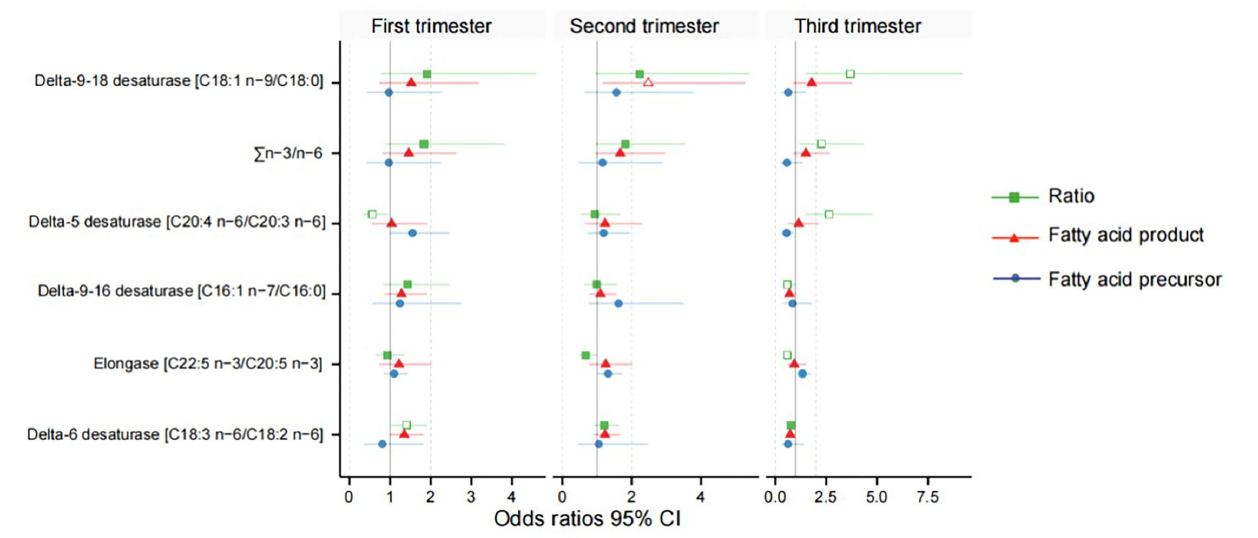
FIGURE 3 | Odds ratios between the desaturase activities and gestational diabetes mellitus. Green indicates the fatty acid product-to-precursor ratios; red indicates the fatty acid product; blue indicates the fatty acid precursor. A hollow shape represents the difference is significant, and solid is non-significant.